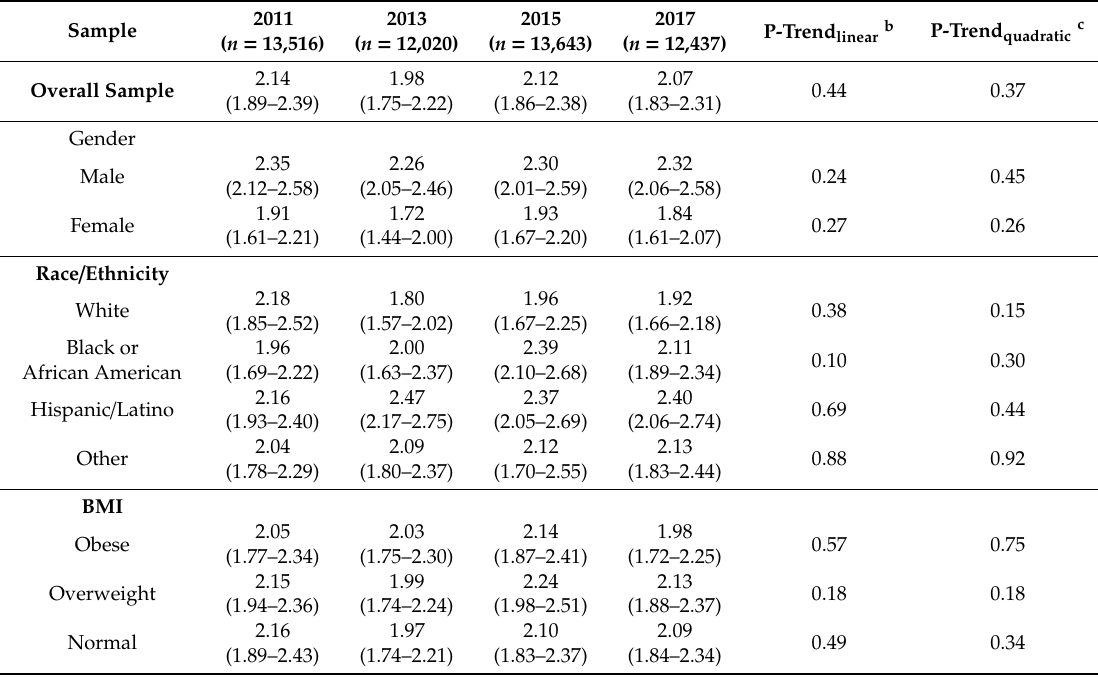
Figure 1. Weighted mean number of participation in physical education for the overall sample from 2011 to 2017 ( N = 51,616).